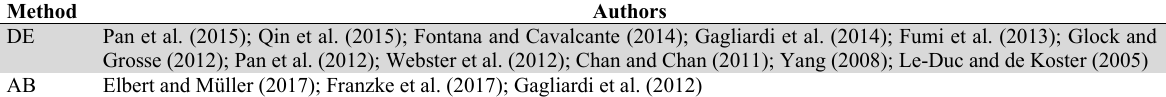
Relationship between simulation methods and authors